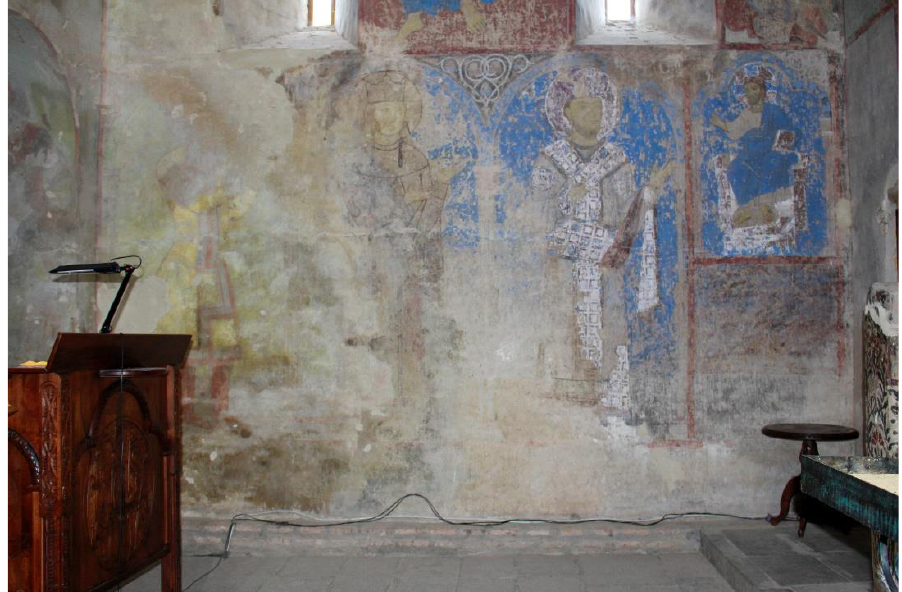
Figure 3. Queen T’amar alongside her deceased father Giorgi III and her heir co-monarch Lasha (future King Giorgi IV), fresco, c. 1206/7, church of Saint Nicholas at Q’intsvisi monastery (Photograph: Neli Chakvetadze).